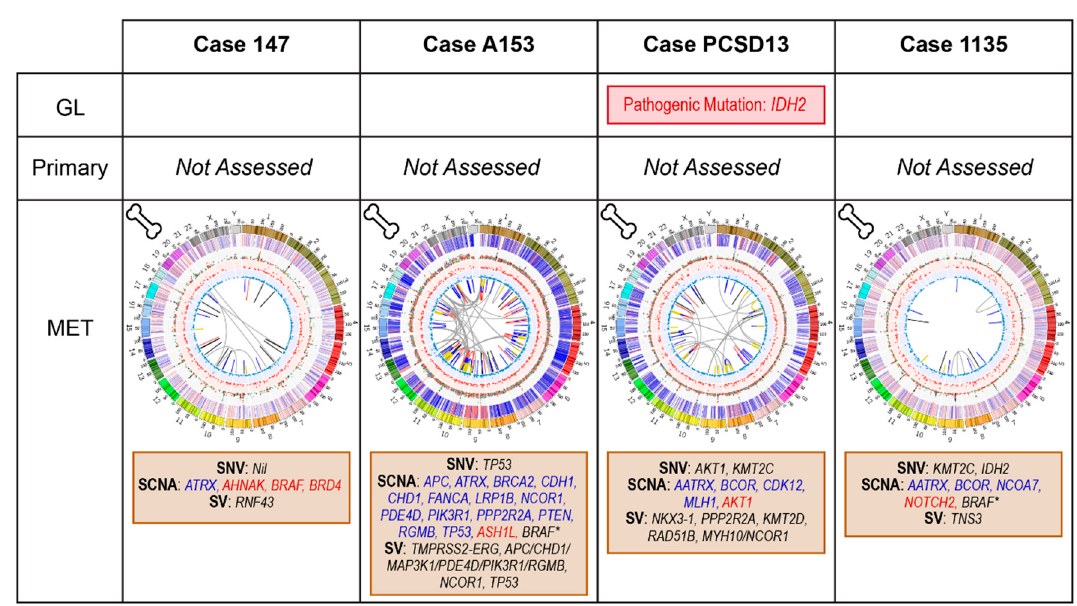
Figure 6. Summary of relevant genomic alterations for cases with metastatic disease at the time of sampling (cases 147, A153, PCSD13, 1135); Circos plots as per Figure